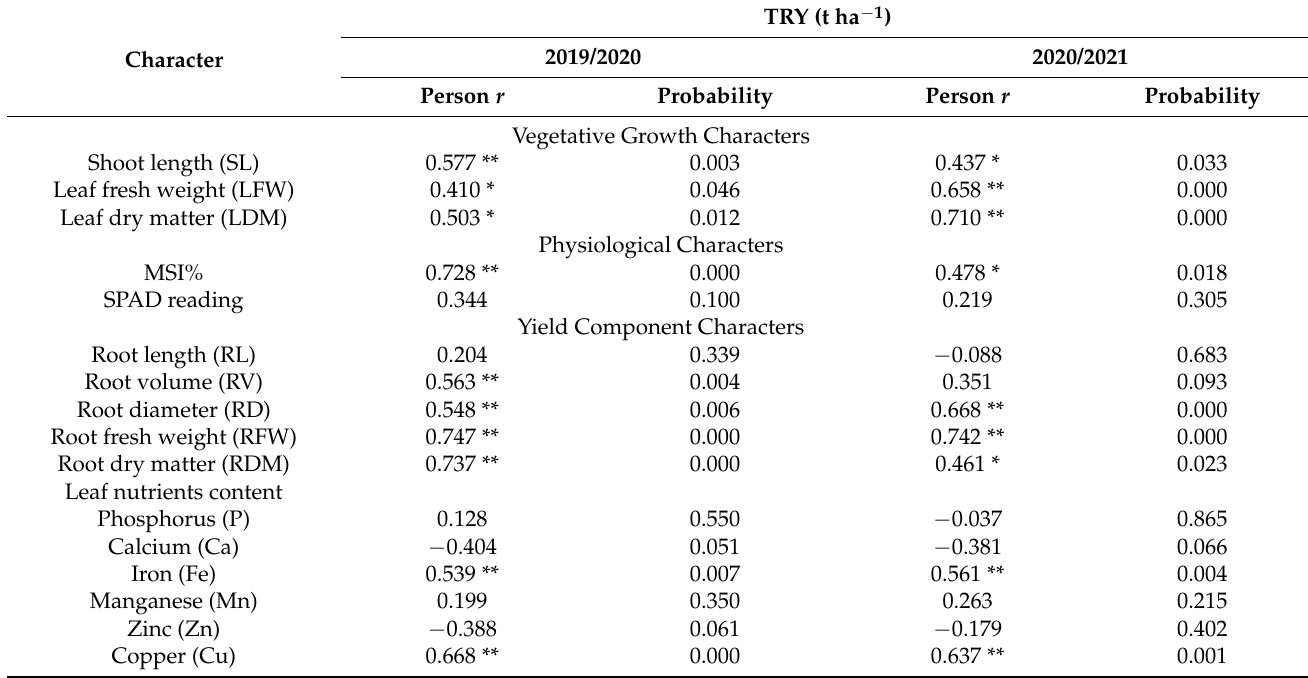
Table 8. Pearson’s correlation coefficients between total root yield (TRY) with some selected attributes of Zn-stressed carrot plants nourished by foliar spraying with different doses of zinc oxide nanoparticles in two